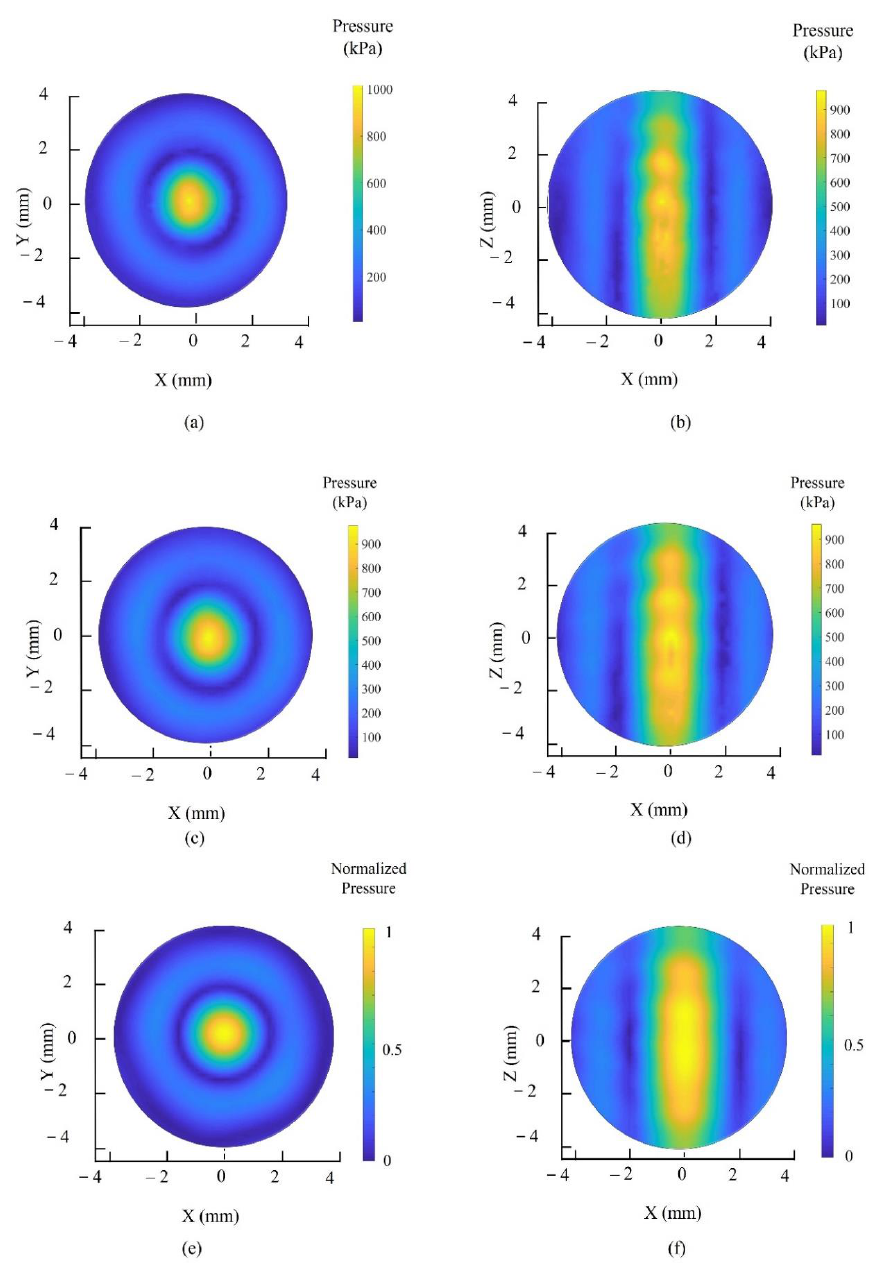
Figure 6. The 3D scanned pressure field for a single beam: ( a ) the scanned pressure in the O-XY plane; ( b ) the scanned pressure in the O-XZ plane; ( c ) the scanned pressure in the O-XY plane with PRCM; ( d ) the scanned pressure in the O-XZ plane with PRCM; ( e ) the simulation pressure in the O-XY plane with 200 μ m of each data point; ( f ) the simulation pressure in the O-XZ plane with 200 μ m of each data point.